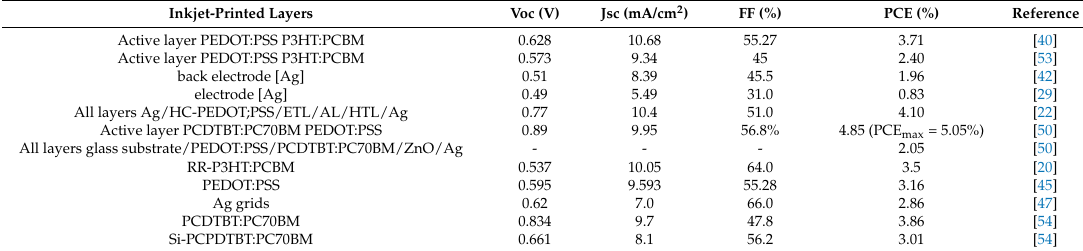
Table 3. Power conversion efficiency (PCE) table of inkjet-printed organic solar cells